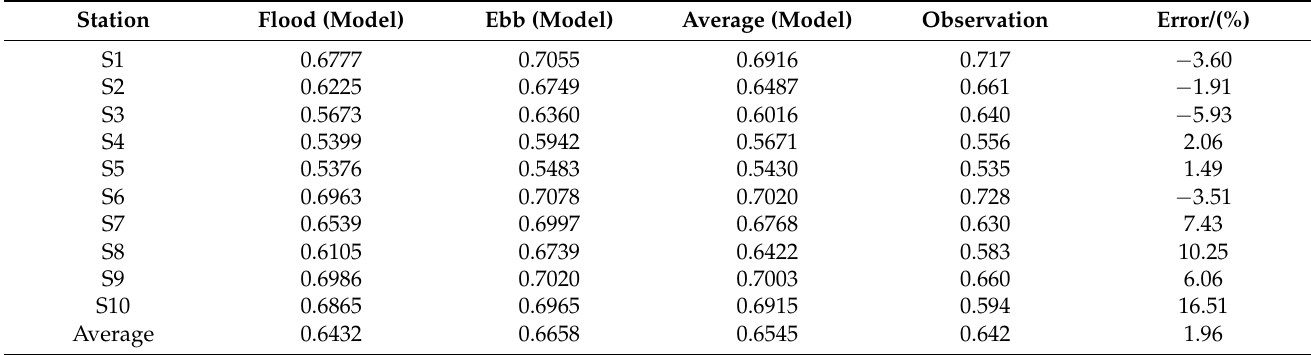
Table 1. Validation of COD.